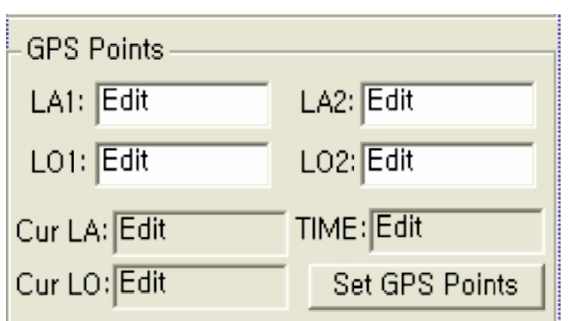
FIG. 27 COMPUTER SIMULATION WINDOW OF